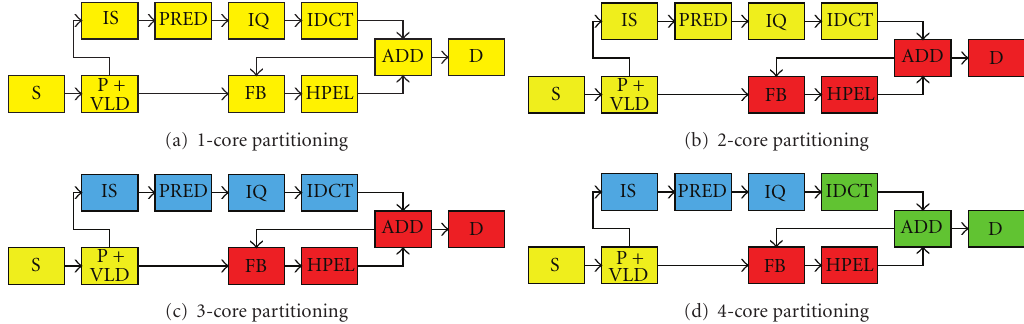
Figure 8: Partitions of the serial version of the MPEG-4 SP decoder for 1, 2, 3, and 4 cores configurations.